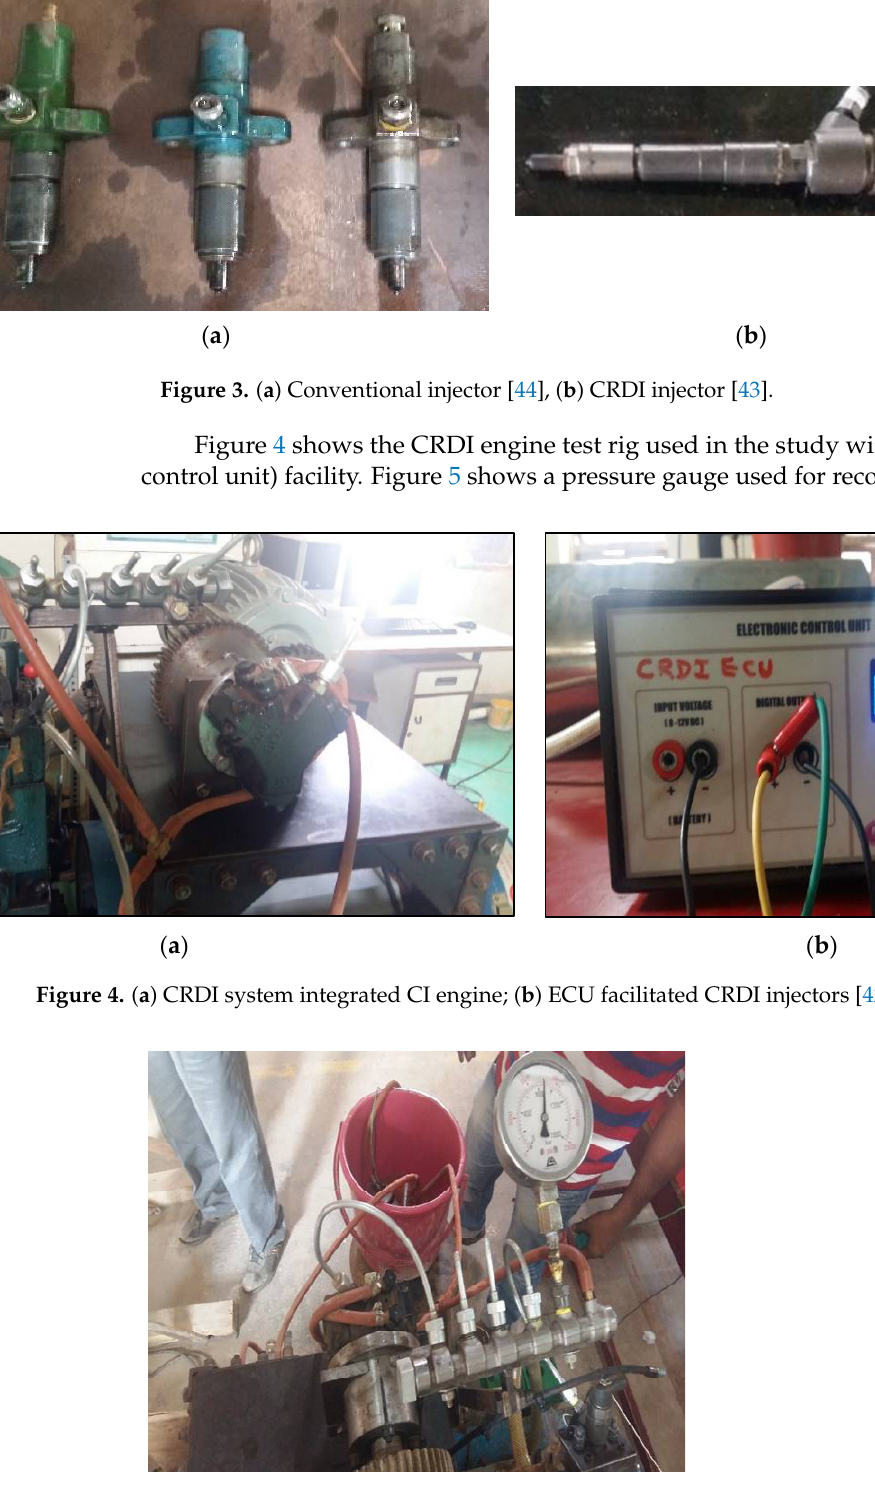
Figure 2. Schematic view of the experimental test rig (adapted from [43], Elsevier, Amsterdam, The Netherlands, 2021).